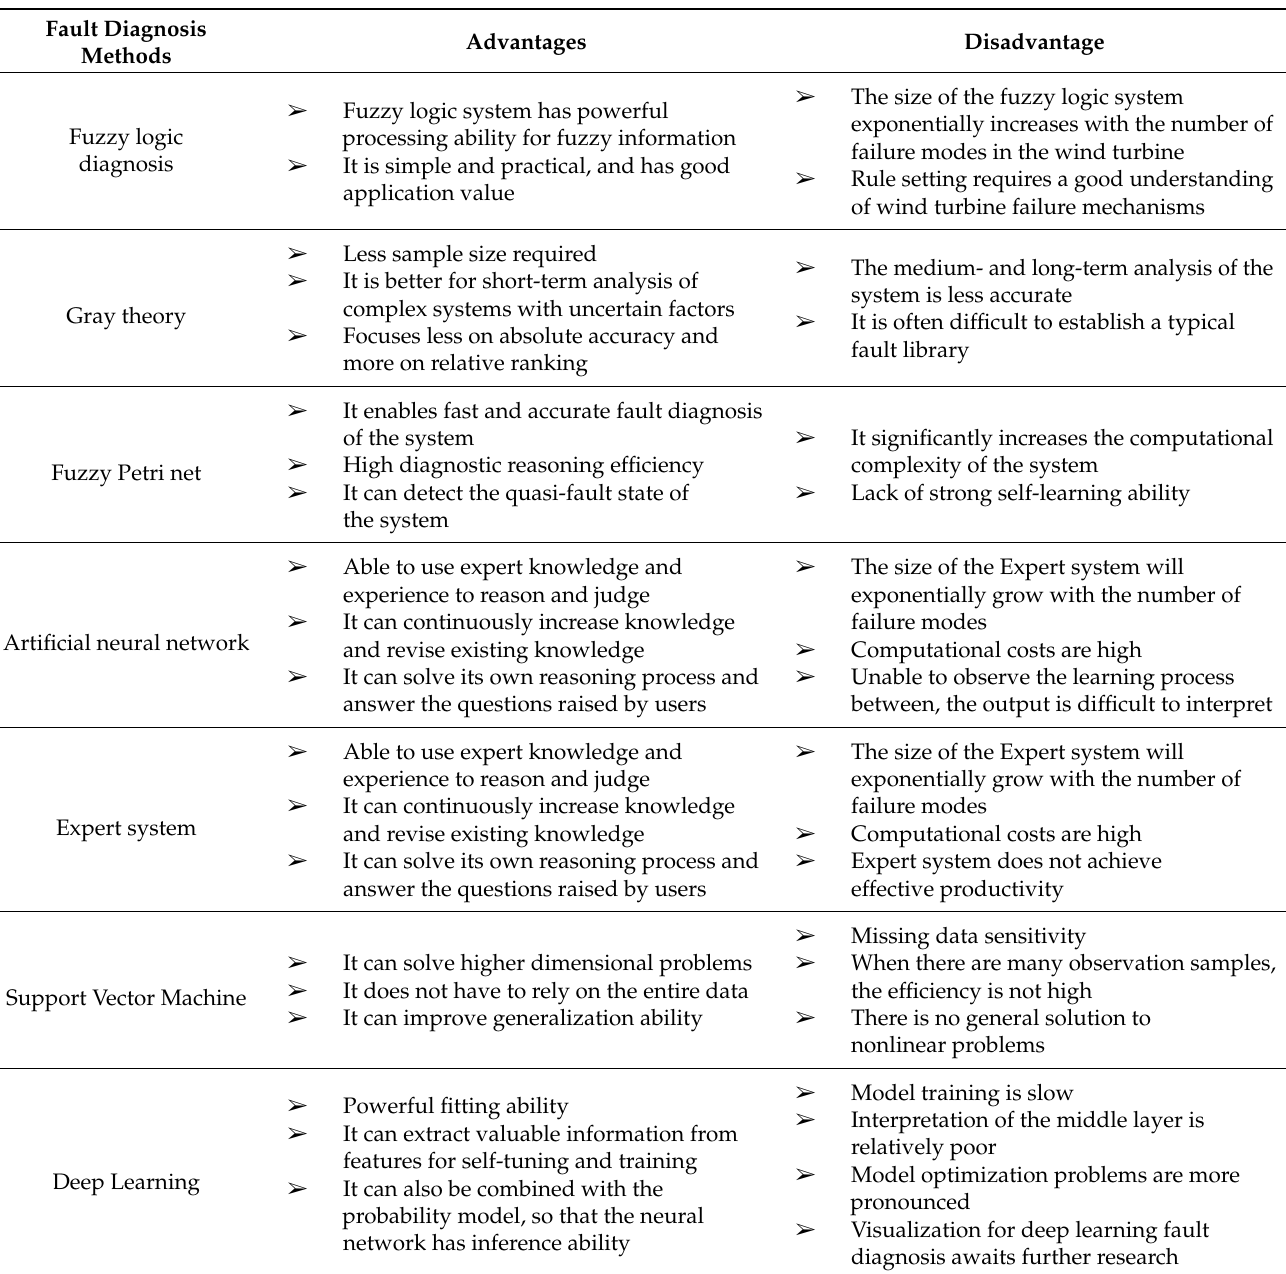
Table 2. Comparison of current fault diagnosis methods for wind